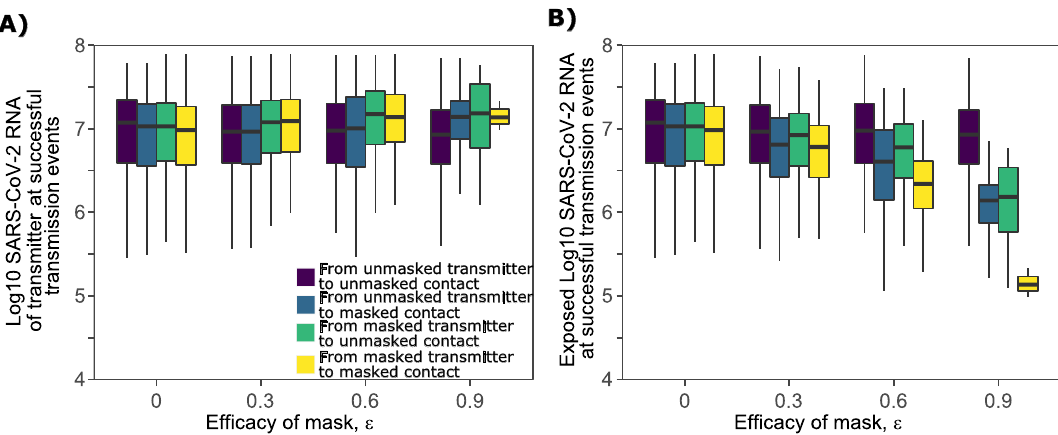
Figure 5. Effect of mask efficacy on exposure viral load during successful transmissions. Viral loads of the transmitter plotted against mask efficacy. Colors indicate masking conditions (see legend). Each boxplot in each panel is based on simulations of 3000 transmitters with varying daily exposure contacts. ( A ) Viral load of transmitters and ( B ) viral load exposure in infected